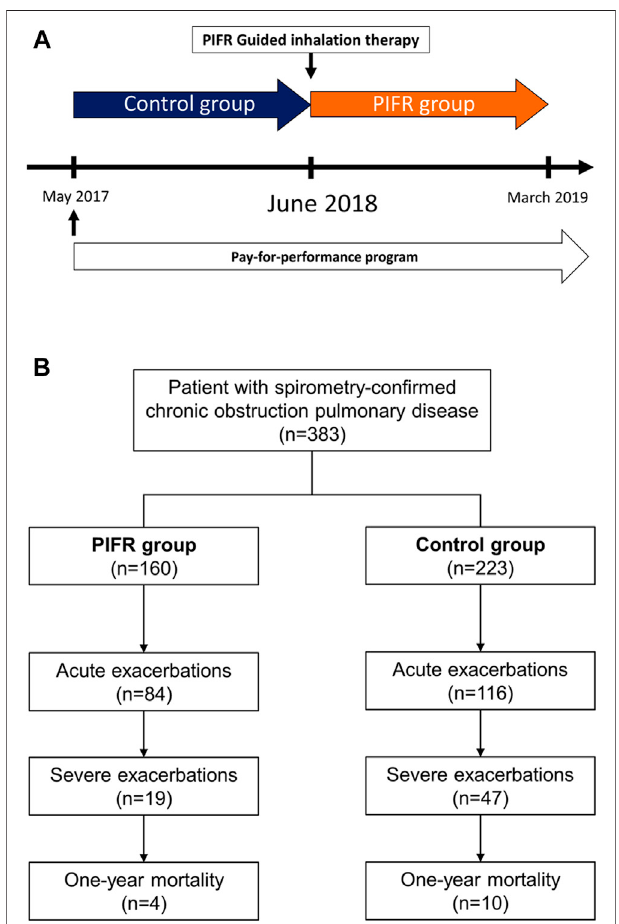
FIGURE 2 | (A) A mirror image study design comparing patients with COPD before and after the introduction of peak inspiratory fl ow rate guided inhalation therapy. (B) Flow chart depicting the enrollment. PIFR group: patients who received PIFR-guided inhalation therapy.